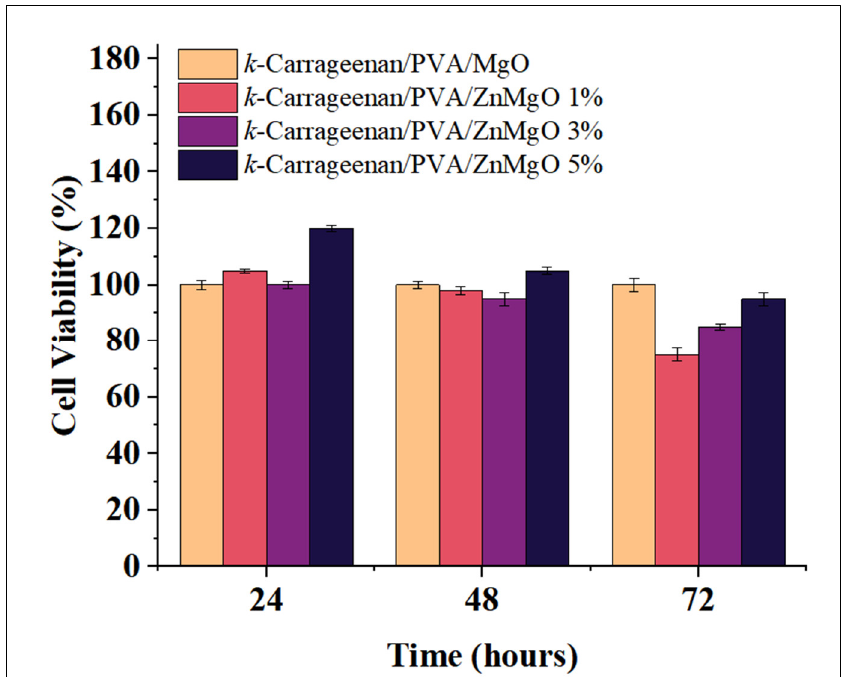
Figure 4. Cellular proliferation analysis (MTT) of k -carrageenan/PVA hydrogel films with different nanoparticle ratios against L929 cells.